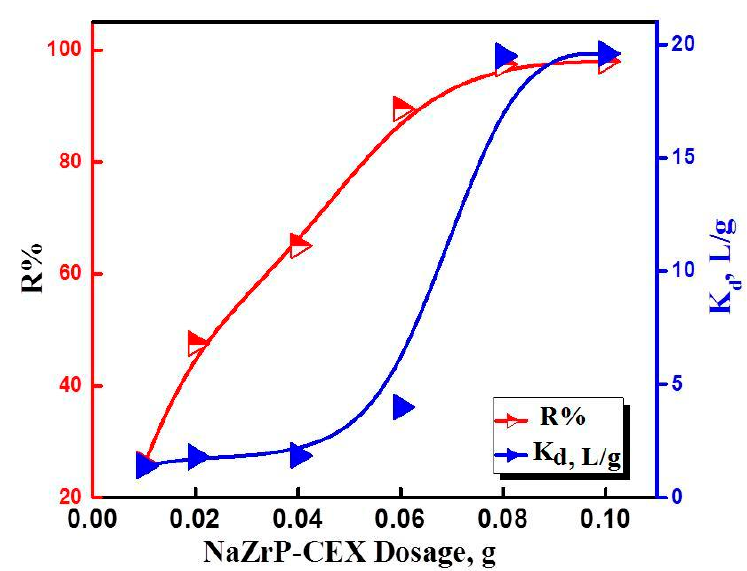
Figure 5. E ff ect of NaZrP-CEX doses and distribution coe ffi cient (K d ) for UO 22 + adsorption onto Figure 5. Effect of NaZrP-CEX doses and distribution coefficient (K d ) for UO 22+ adsorption onto NaZrP-CEX NaZrP-CEX cation-exchanger.